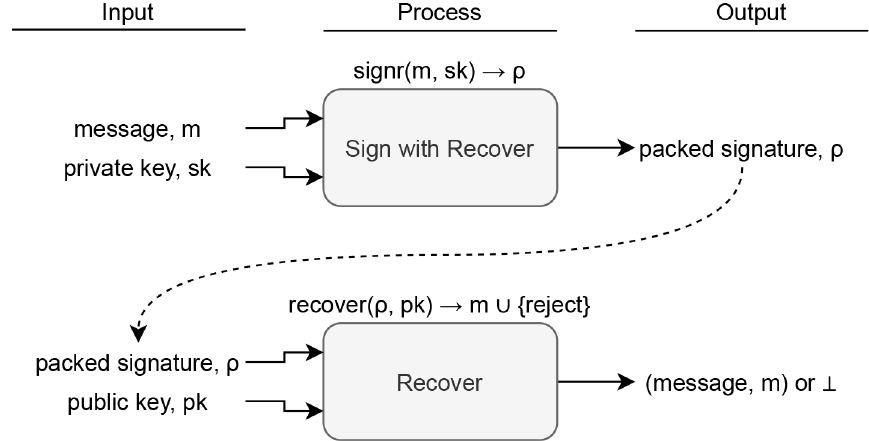
Figure 2. Sign and verify process for a digital signature scheme with message recovery.